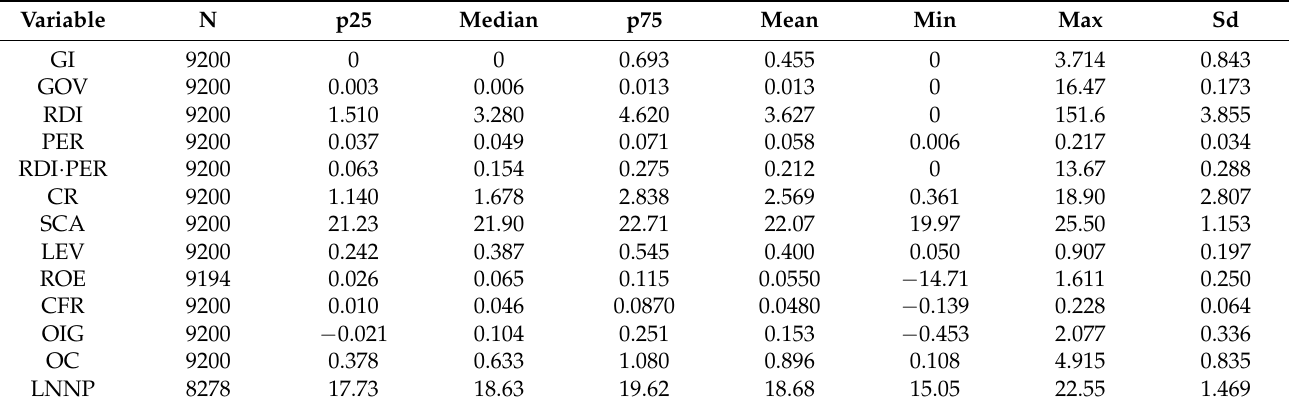
Table 2. Descriptive